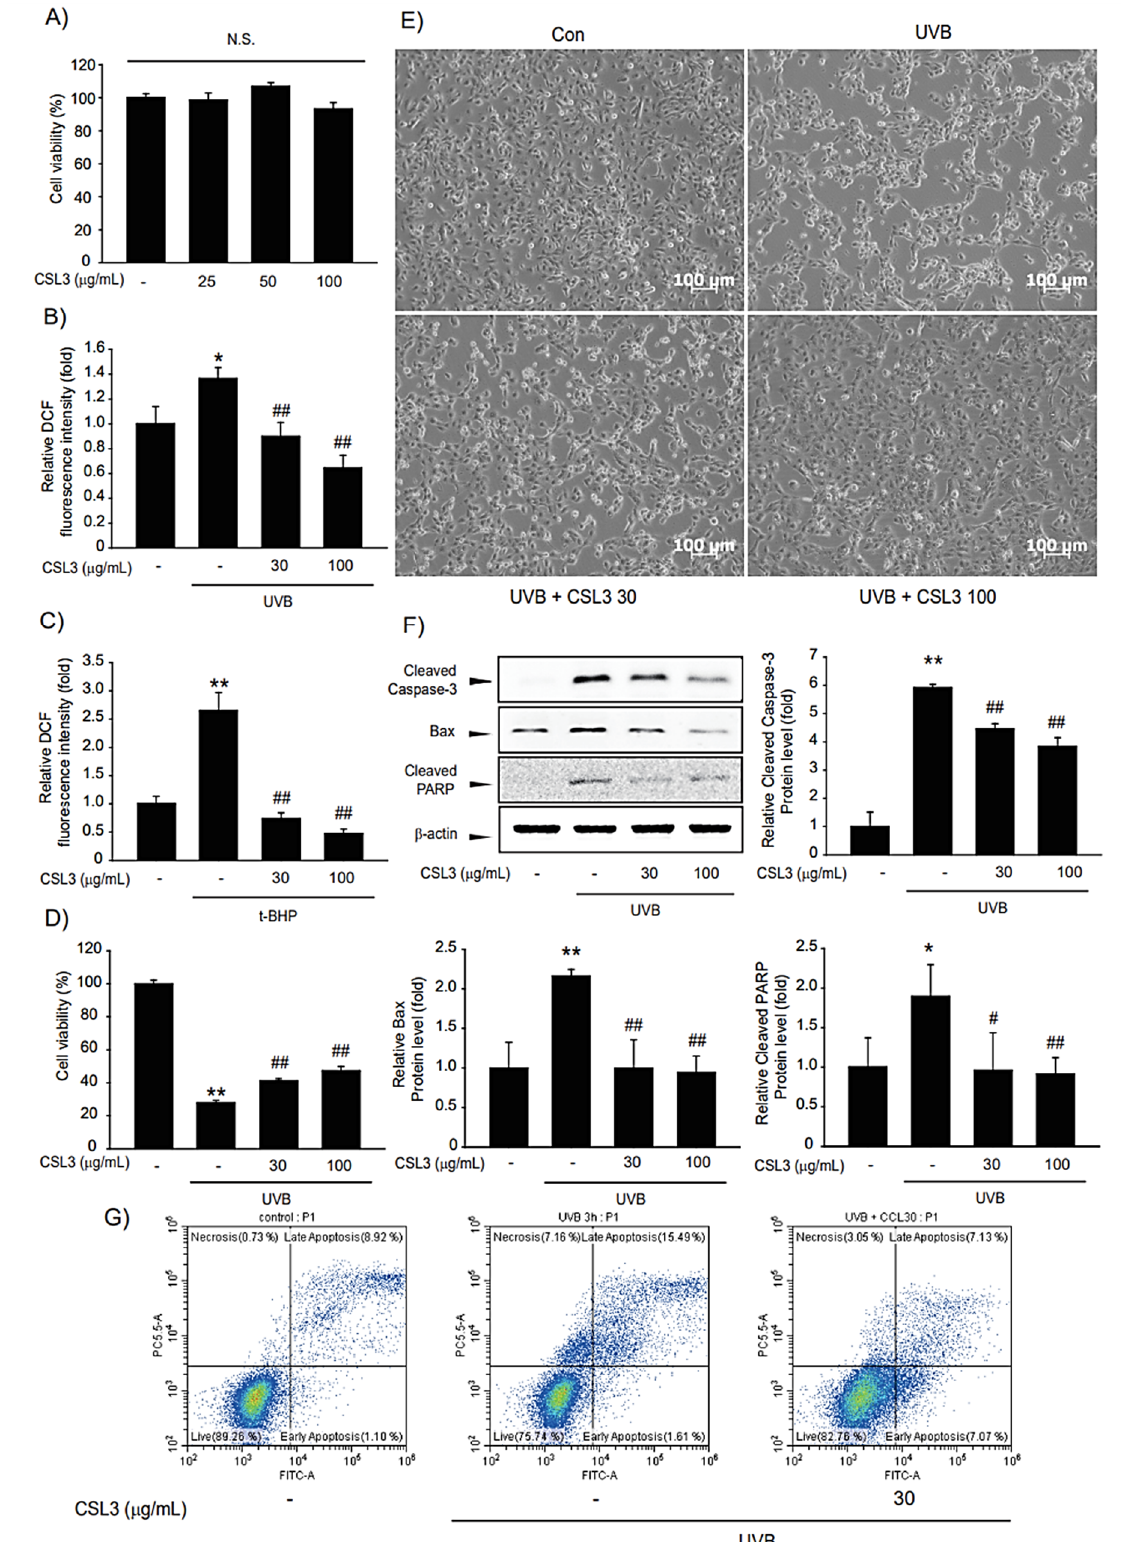
Figure 4. Effects of CSL3 on the viability of HaCaT cells. ( A ) The cytotoxic effect of CSL3 in HaCaT cells was determined by MTT assays. Cells were treated with CSL3 (25–100 µ g/mL) for 12 h. Data represent means ± S.E. of 3 replicates; significant when compared with respective controls, N.S.— not significant. ( B , C ) The effect of CSL3 on intercellular ROS production induced by UVB irradiation (30 mJ/cm 2 ) or t -BHP treatment (600 M) in HaCaT cells. First, we pre-treated with CSL3 (30–100